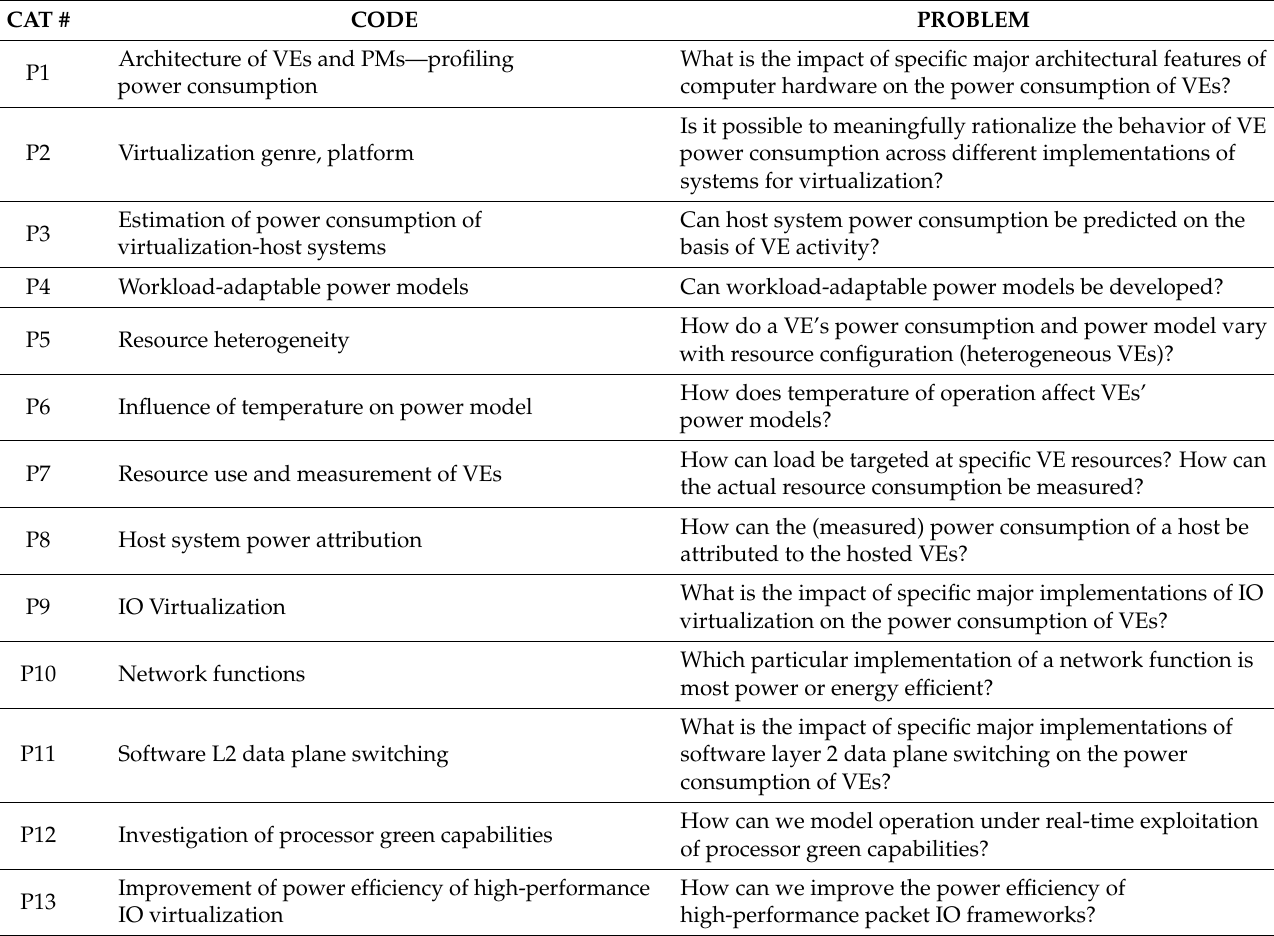
Figure 22. Normalized frequency of Developments. Table 2. Challenge category codes and representative challenge